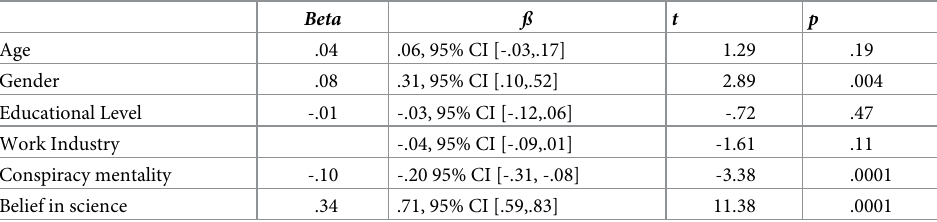
Table 6. Beta, B, t, and p values for predictors for the multiple regression analysis.